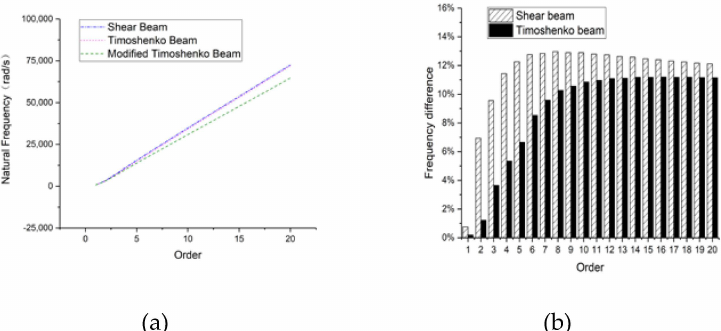
Figure 21. Natural frequencies of the 2-m-long beam: ( a ) overall frequency curve and ( b ) frequency di ff erence compared with a modified Timoshenko